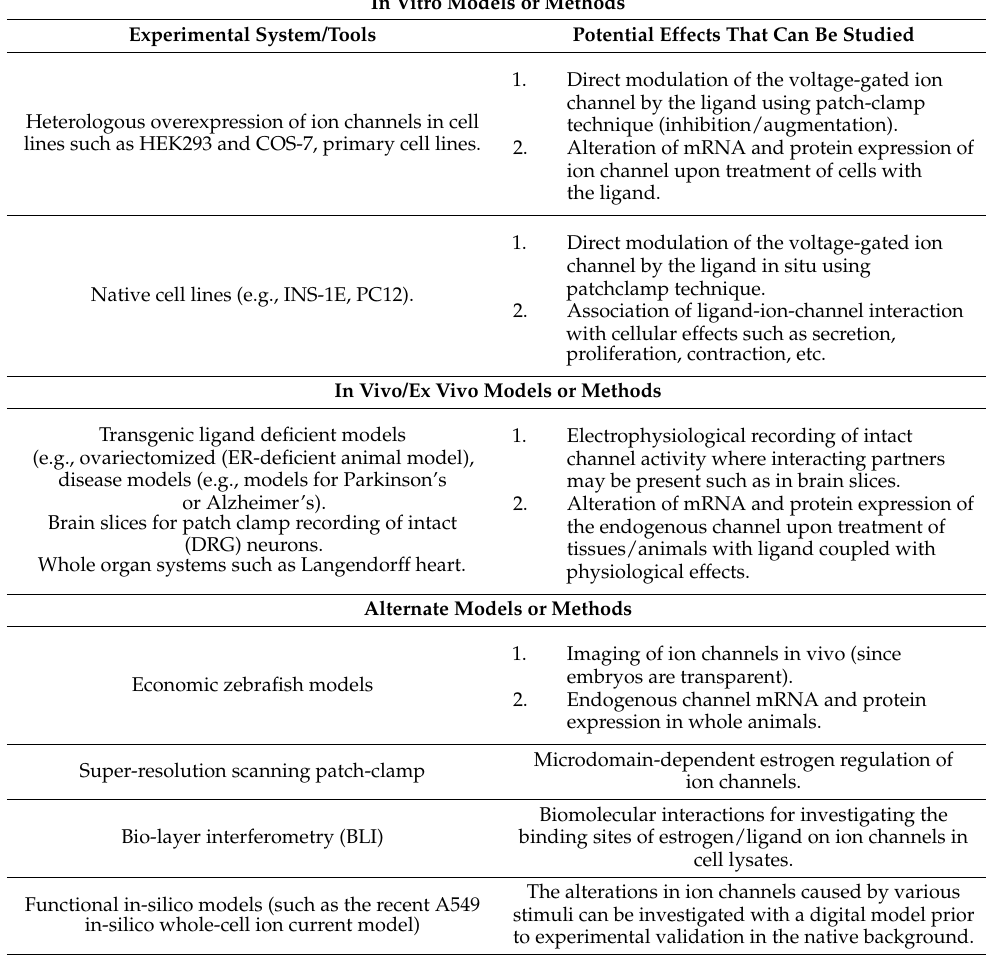
Table 4. Models/tools to study ligand-voltage-gated ion channel interaction. In Vitro Models or Methods Experimental